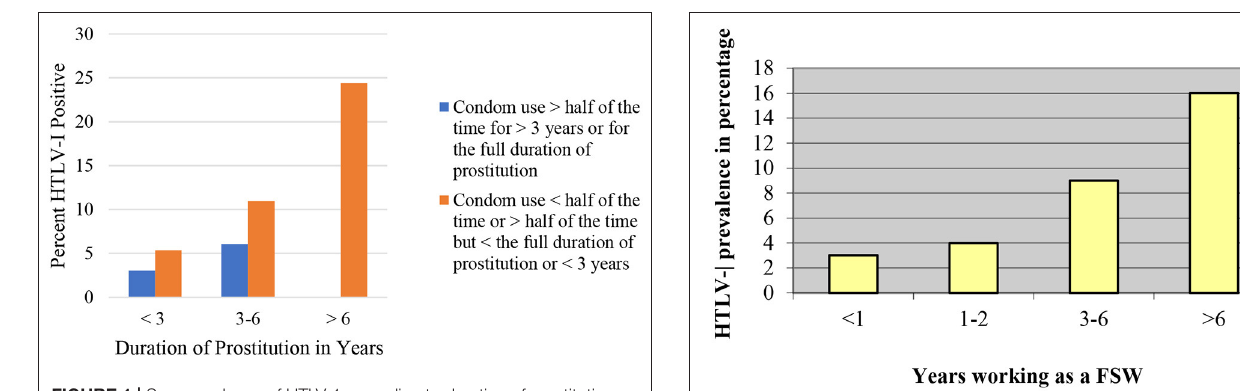
infection was significantly associated with older age ( p <